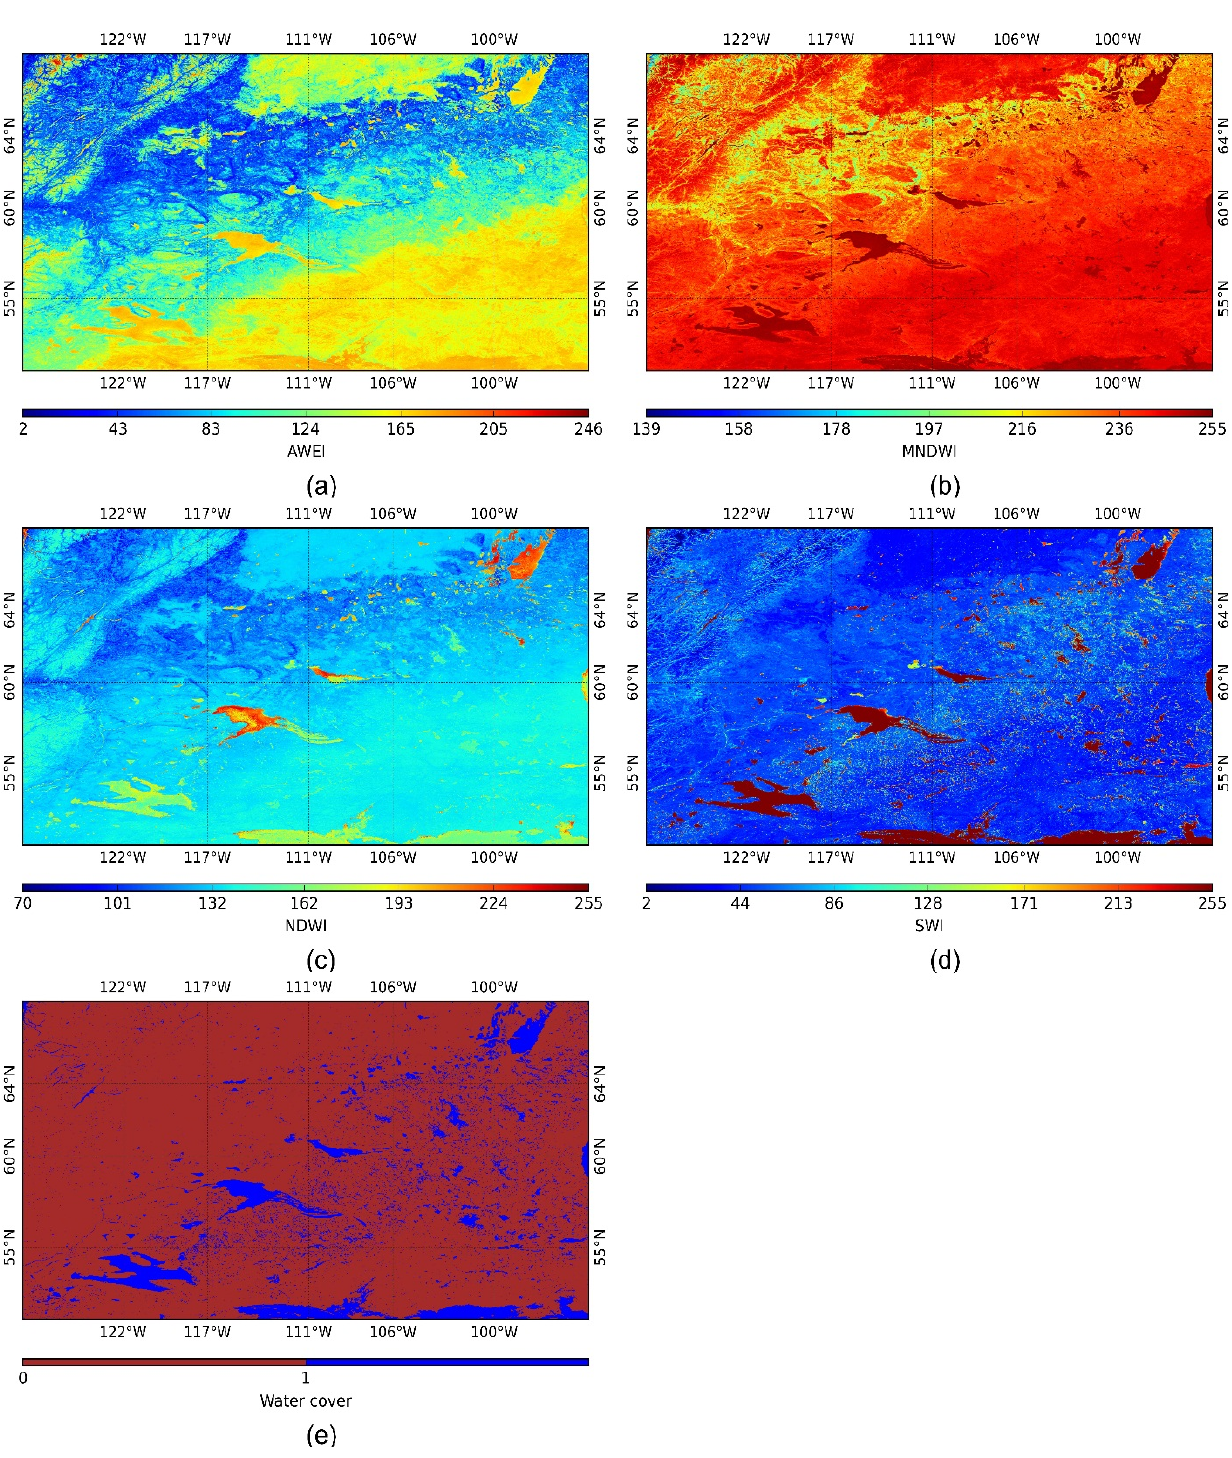
Figure 3. Plotting of four water indices and water cover map in a snowy region: ( a ) Automated Water Extraction Index (AWEI), ( b ) Modified Normalized Difference Water Index (MNDWI), ( c ) Normalized Difference Water Index (NDWI), ( d ) Superfine Water Index (SWI), ( e ) Reference water cover